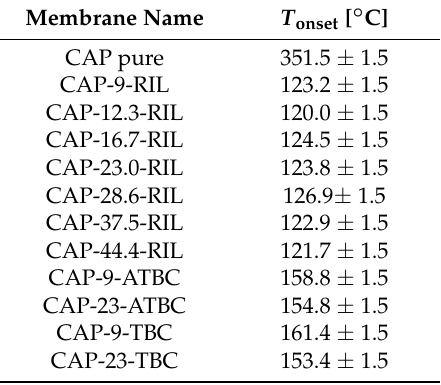
Table 3. Onset temperature of the initial decomposition for CAP-RIL, CAP-TBC, and CAP-ATBC